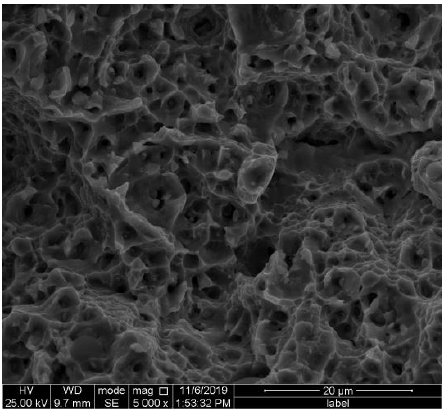
Figure 11. SEM morphology of dimpled ductile fracture surface of Fe – 28Mn – 10Al – C – 0.5Nb low- density